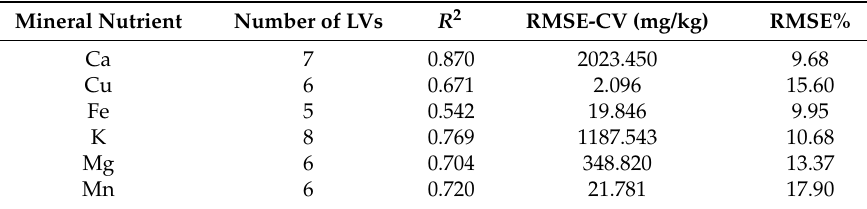
Table 3. Results of the optimal model’s performance in predicting mineral nutrients. Mineral Nutrient Number of LVs R 2 RMSE-CV (mg/kg) RMSE%